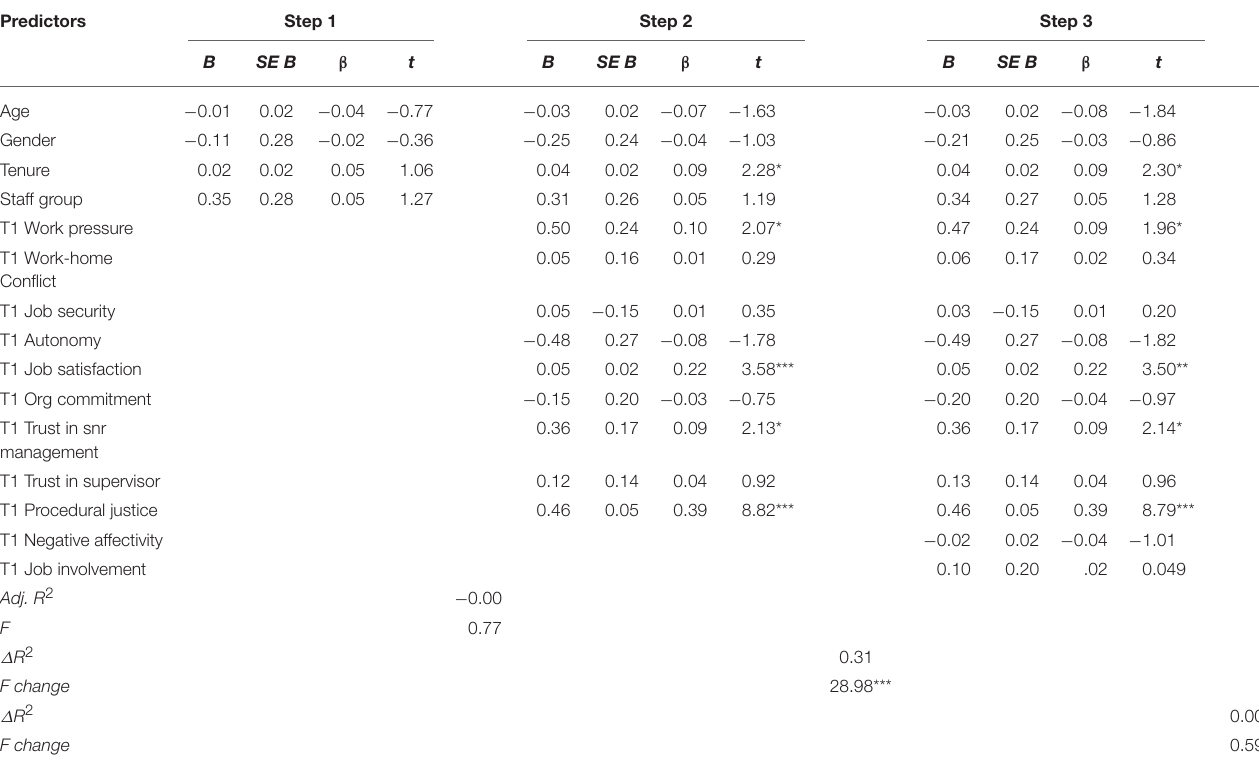
TABLE 3 | Multiple regression analyses of all predictors of T2 procedural justice for all study participants.